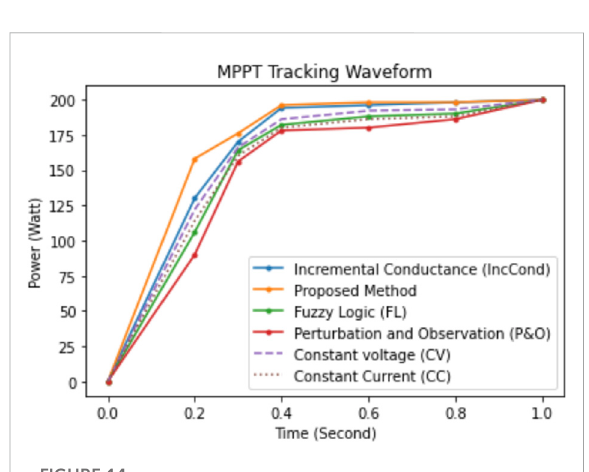
FIGURE 14 MPPTtrackingwaveformsoftheproposedmethodandother conventional